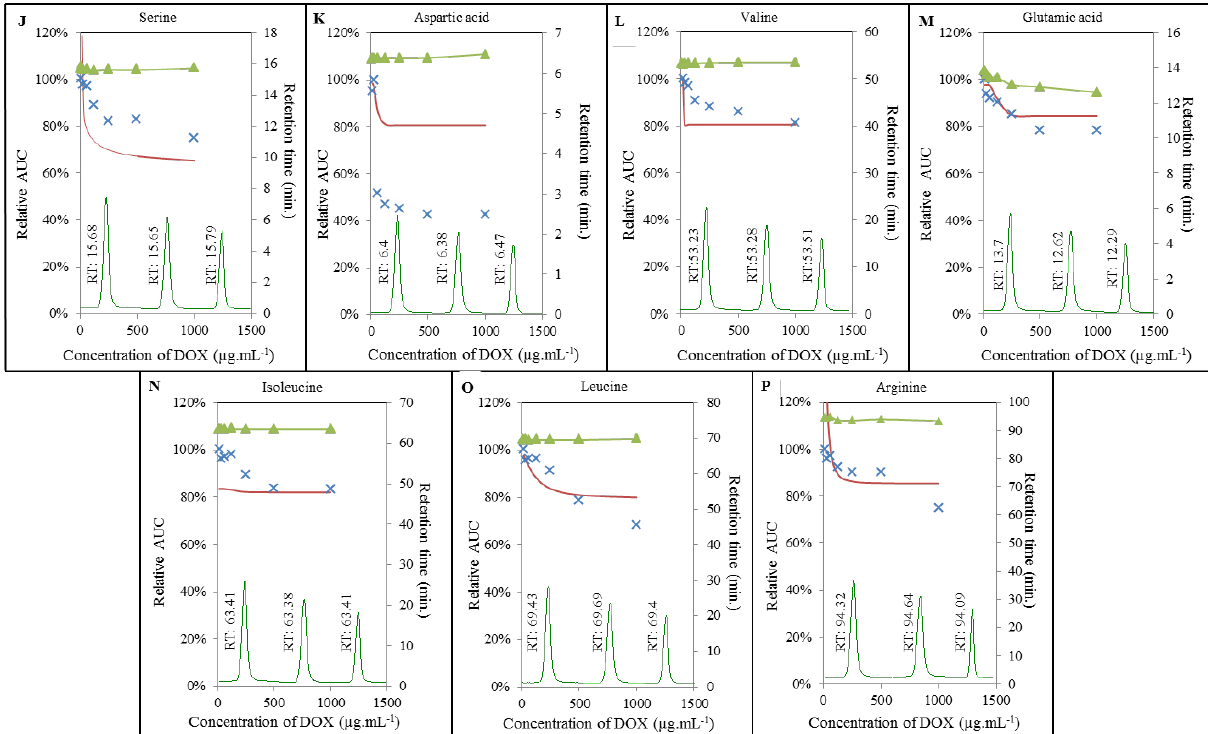
Figure 5. Interaction of amino acids (100 µmol mL −1 ) with doxorubicin (8; 16; 32; 62; 125; 250; 500; 1000 µg mL −1 ) monitored with IELC. DOX interaction with: ( J ) serine; ( K ) aspartic acid; ( L ) valine; ( M ) glutamic acid; ( N ) isoleucine; ( O ) leucine; ( P ) arginine. ▲ Expression of retention time changes (min); × real curve of a sample and—calculated overlay expressing amino acids breaking